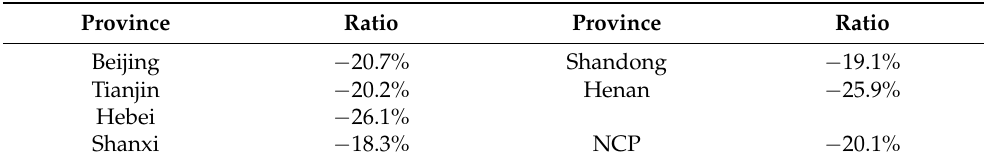
Table 1. The estimation of SO 2 emission reduction ratios in NCP and different provinces during the lockdown